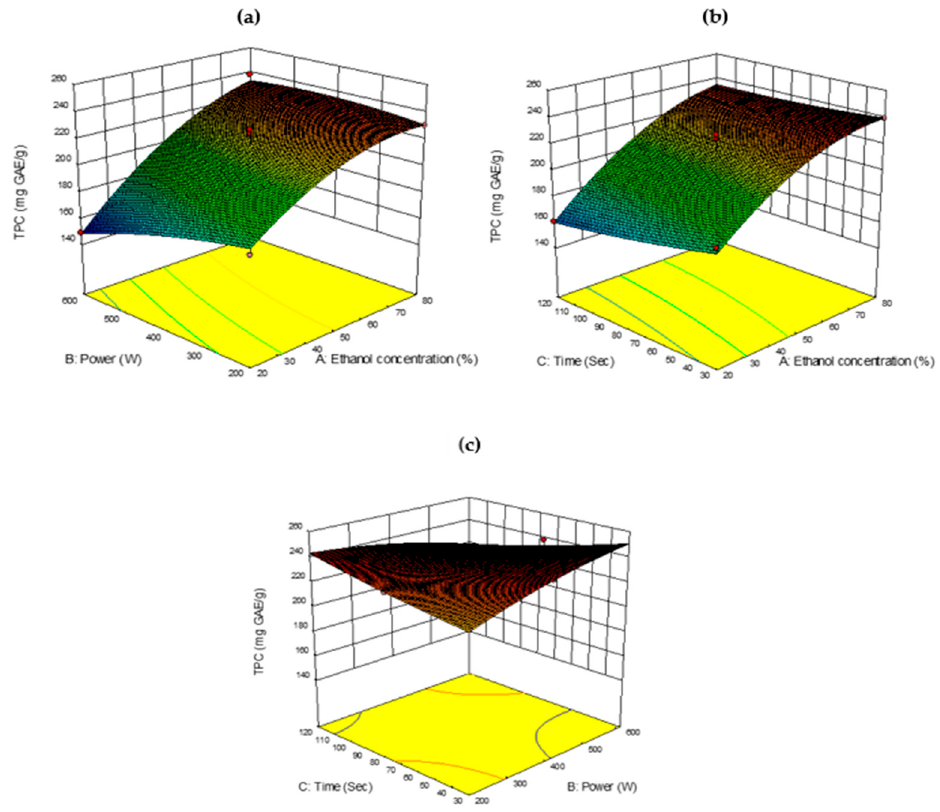
Figure 2. Response surface analysis (3D) of Barleria lupulina Lindl. leaf extract (BLLE) on total phenolic content (TPC): ( a ) effect of ethanol concentration and power; ( b ) effect of ethanol concentration and time; ( c ) effect of power and time.